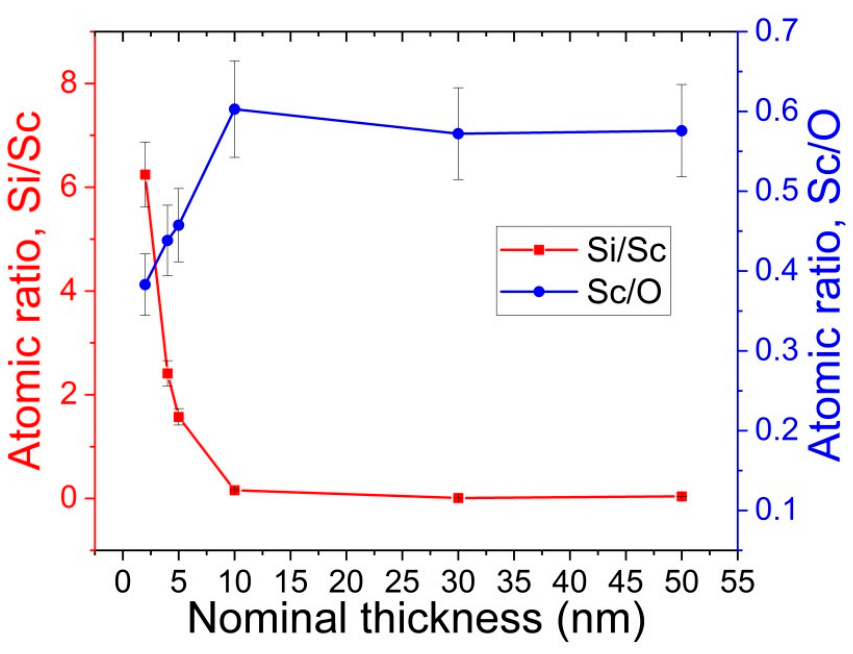
Figure 1. Plot of the Si/Sc and Sc/O ratios vs nominal thickness.